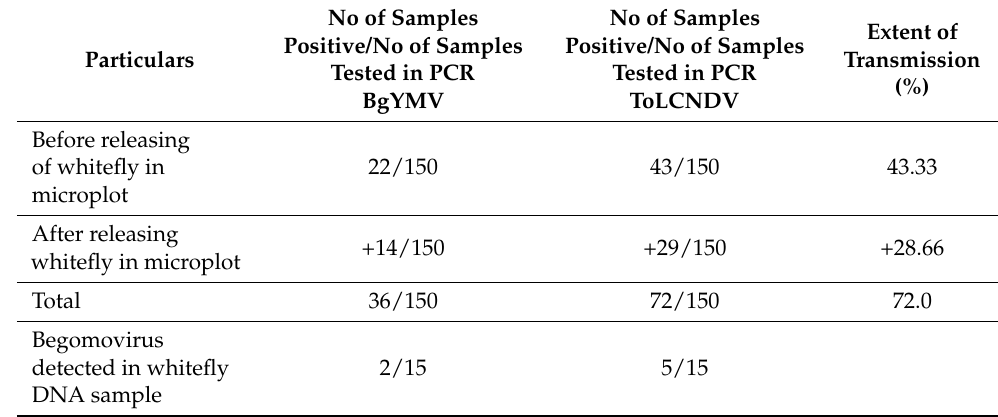
Table 6. Extent of spread of begomoviruses from seedling borne inoculum through the vector B. tabaci in microplot